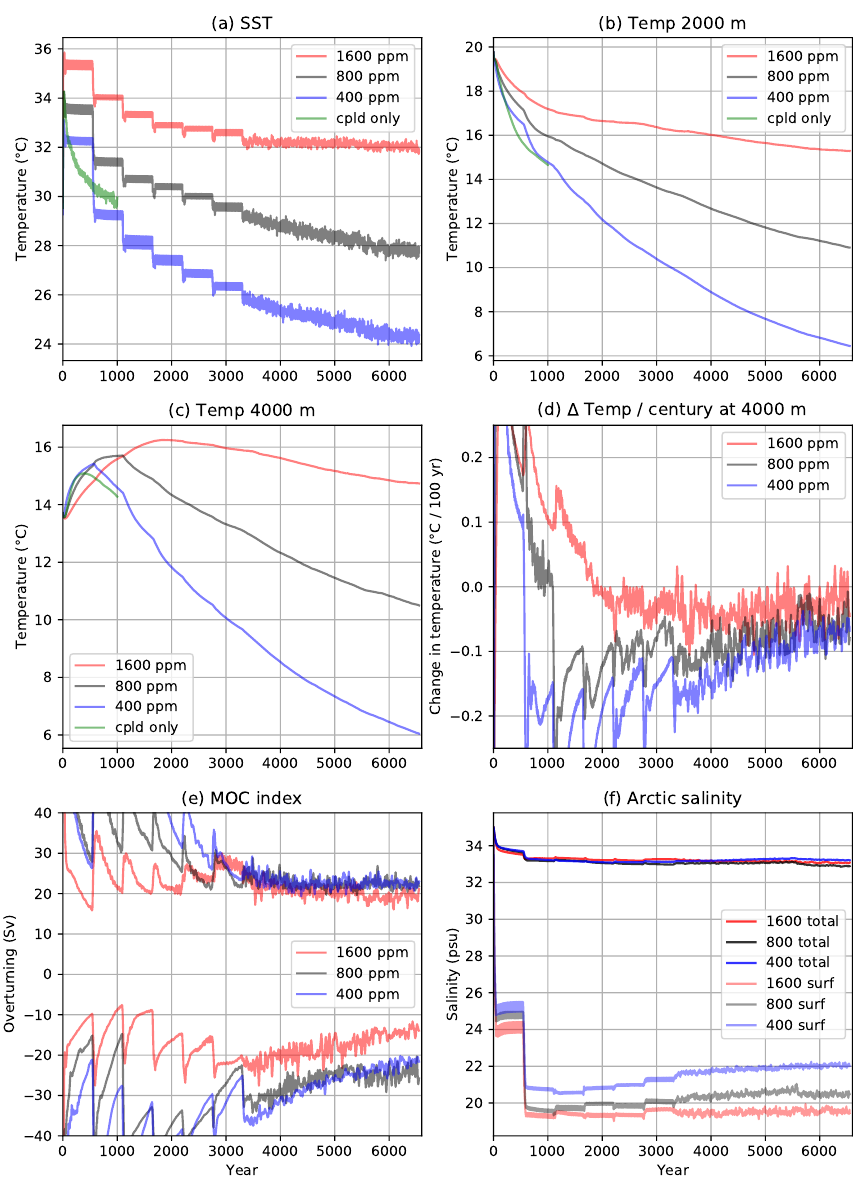
Figure 2. Spin-up evolution of the 400, 800 and 1600ppm simulations, showing the global mean temperature evolution at (a) the surface, (b) 2000m, (c) 4000m and (d) the time rate of change at 4000m. Panels (a–c) also include the 1000-year coupled-only run at 800ppm, illustrating the faster evolution achieved in coupled mode. (e) Meridional overturning circulation (MOC) indices for each simulation: positive values indicate the maximum overturning value in the Northern Hemisphere (NH), while negative values indicate the maximum overturning value in the Southern Hemisphere (SH). (f) Arctic salinity evolution, showing the total (top three curves) and the surface average (bottom three curves). Panels (d) and (e) are filtered using a 21-year running